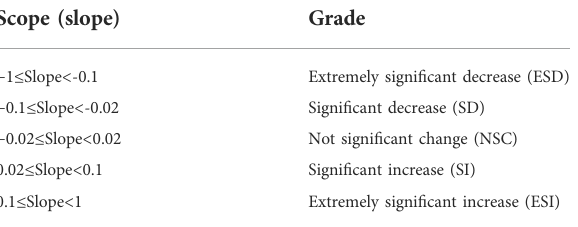
TABLE 2 Classi fi cation of grade for the evolution trend of vegetation coverage in the study area. Scope